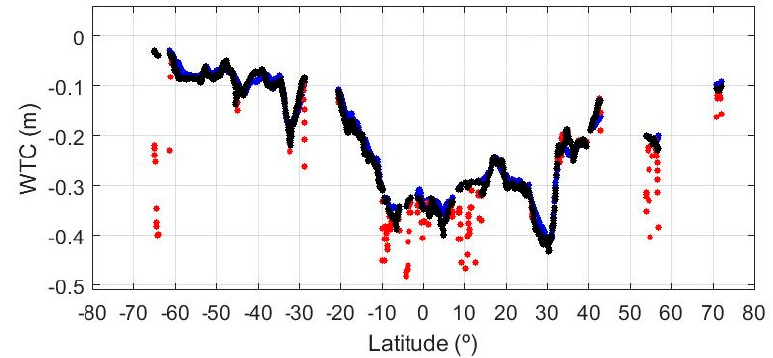
Figure 13. Same as in Figure 12 for S3A pass 462, cycle 06.